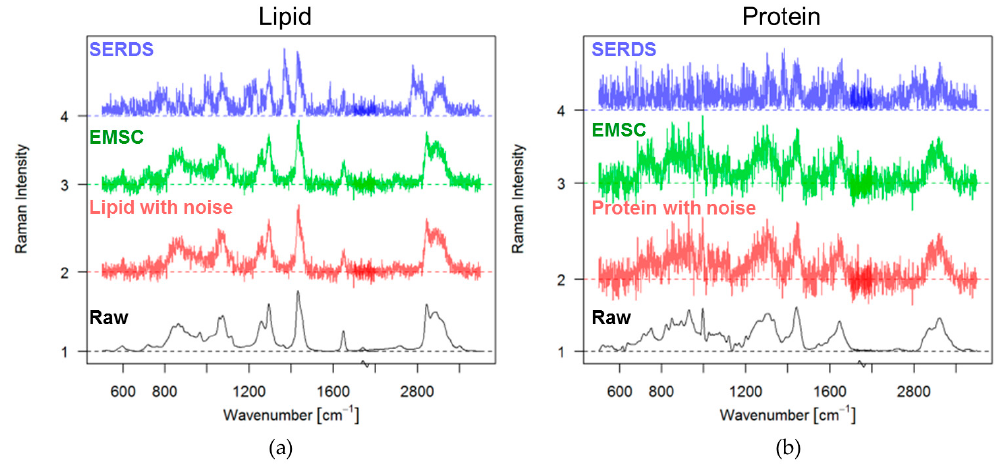
Figure 3. EMSC and SERDS spectra for lipid and protein: ( a ) Lipid spectrum without background (black); lipid spectrum with noise added (red, noise corresponds to the poison distribution of original spectrum and the added fluorescence five times the maximal band of the lipid signal); EMSC corrected lipid spectrum after adding a fluorescence background five times the maximal band of the lipid signal (green); absolute values of SERDS difference spectrum of lipid after shifting 4 nm (blue); ( b ) Protein spectrum without background (black); protein spectrum with noise added (red, this noise corresponds to the poison distribution of original spectrum and the added fluorescence five times the maximal band of the protein signal); EMSC corrected protein spectrum after having fluorescence background five times the maximal band of the protein signal (green); absolute values of SERDS difference spectrum of protein after shifting 4 nm (blue).